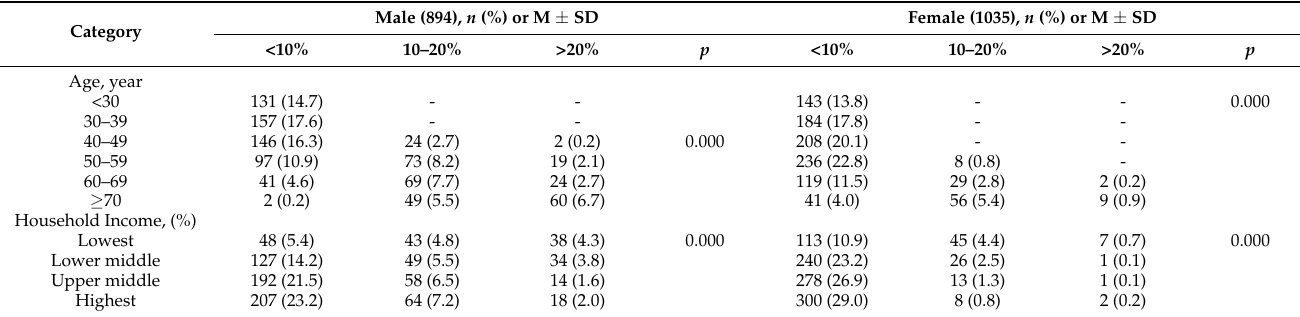
Table 1. Baseline characteristics of participants according to 10-Year CVD Risk (%) ( n =